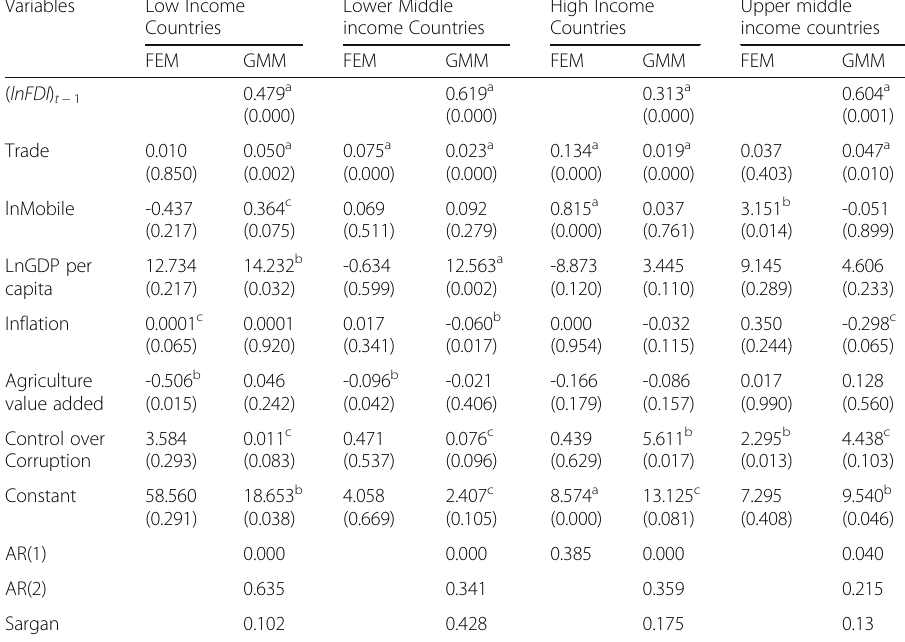
Table 10 Control of corruption and FDI Variables